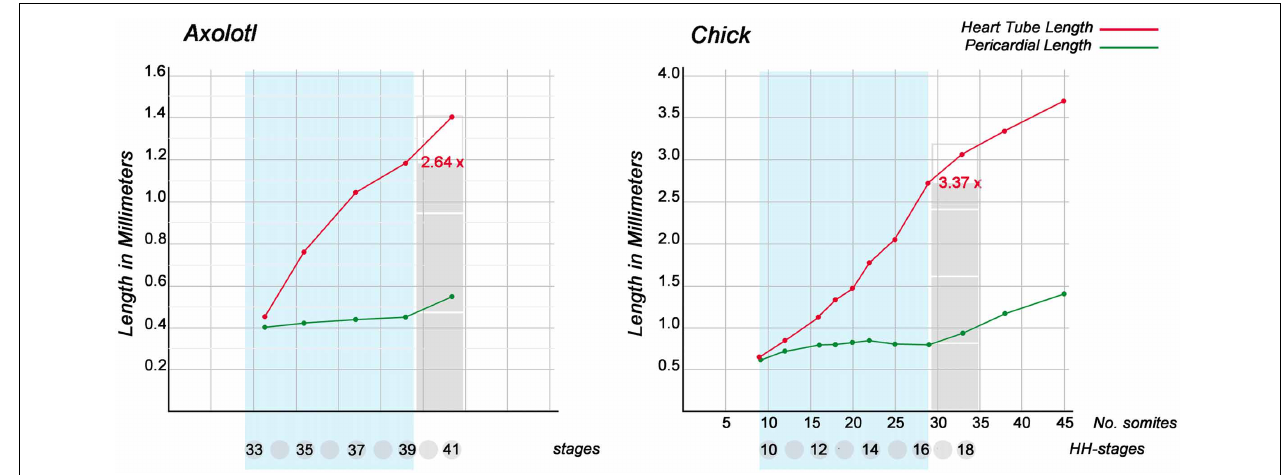
FIGURE 2 | These graphs show the dynamics of the elongation of looping embryonic heart tubes as compared with the cranio-caudal growth of pericardial cavities. Graphs are based on data from Axoltol (Fransen and Lemanski,1988)andchickembryos(Patten,1922).Notethat,duringthephases of dextral-looping and early S-looping (marked in light blue), the cranio-caudal